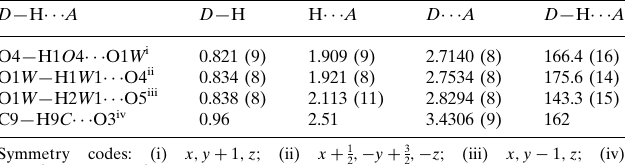
Hydrogen-bond geometry (A˚ , (cid:4) ). D —H (cid:1)(cid:1)(cid:1) A D